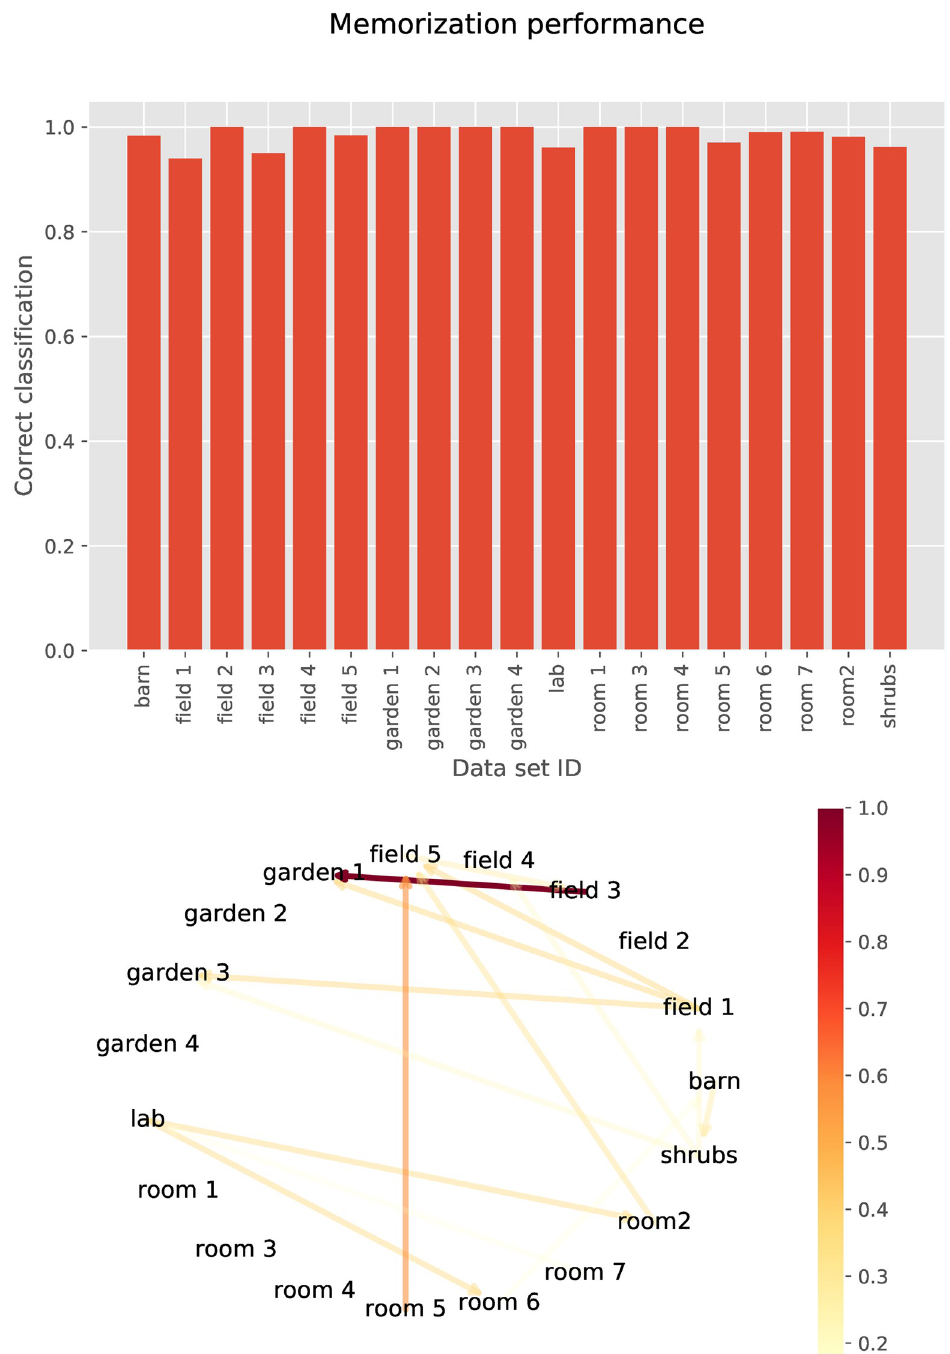
Fig 5. Performance of the neural network memorizing the class membership (=location) of each encoded cochleogram. The bottom panel visualizes the confusion between classes. The arrows show how often members of one class were erroneously attributed to another class. The color and brightness of the error reflect the number of errors. From this graph, it can be seen, for example, that members of Field 3 were most commonly mistakenly classified as Garden 1